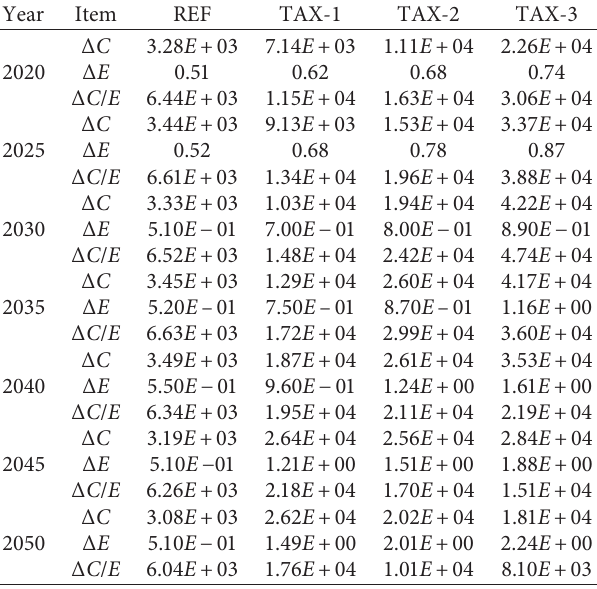
Table 5: CO 2 emission reduction cost of power